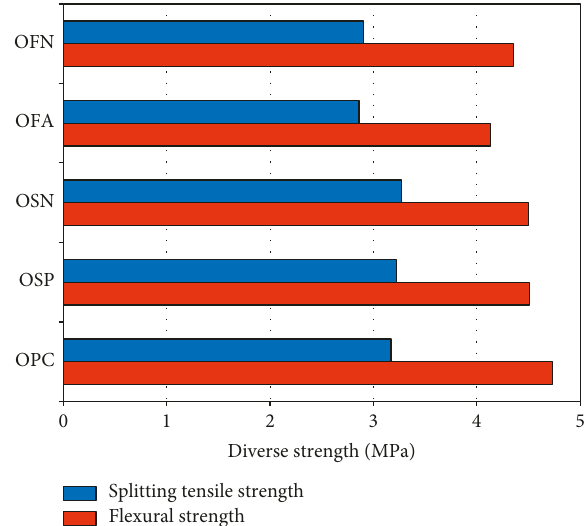
Figure 5: Mechanical strength of concrete at flexural and splitting tensile